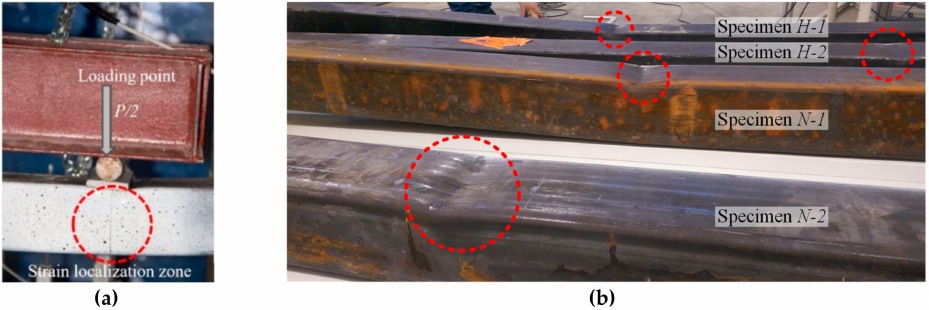
Figure 4. Failure localisation of the beams: ( a ) a typical failure; ( b ) the tested